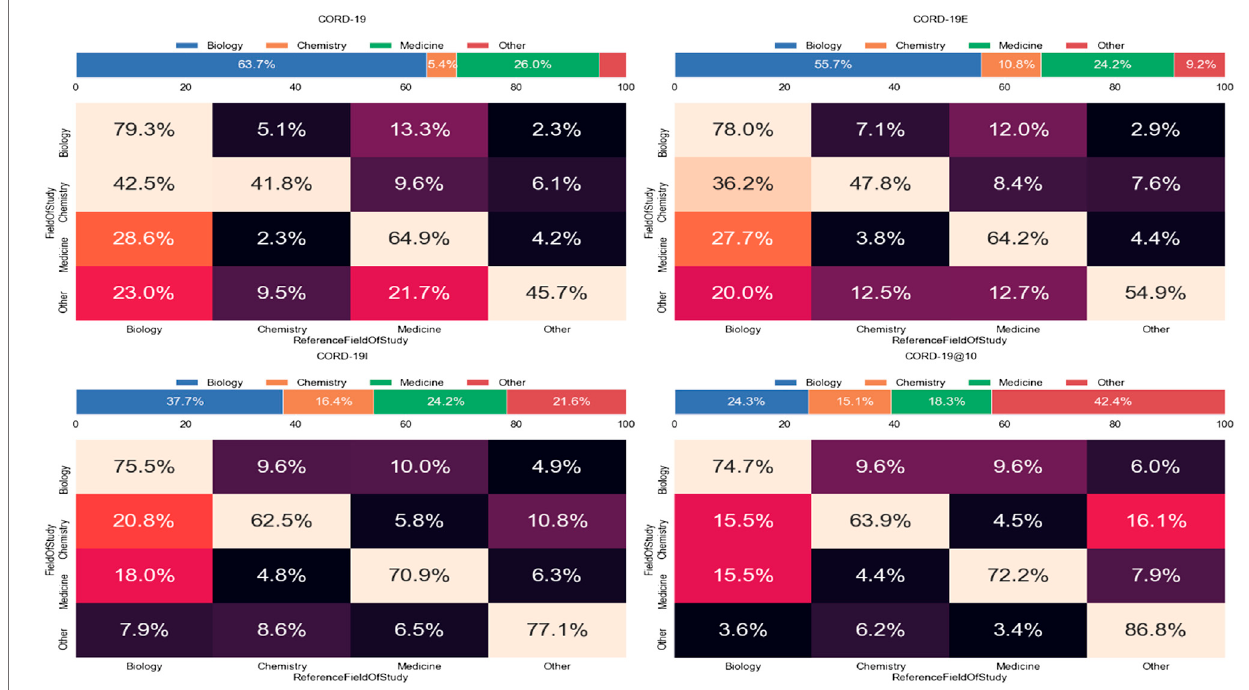
Frontiers in Research Metrics and Analytics |